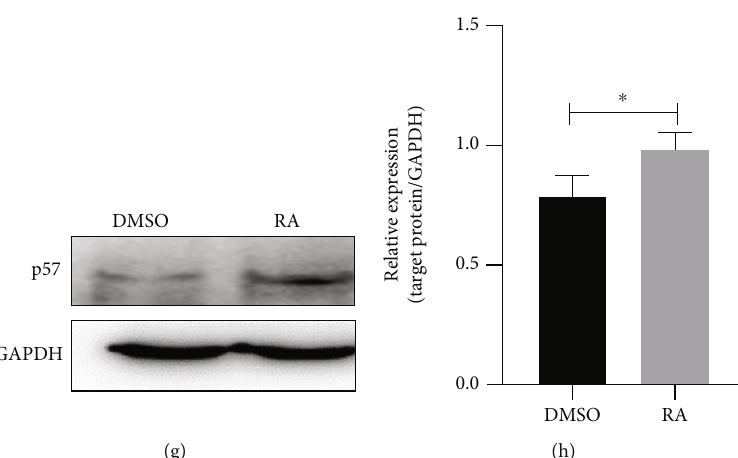
Figure 1: Increased p57 expression during mESC di ff erentiation. (a) The morphology of mESC-derived embryoid bodies (EBs) cultured for 3 days. (b) Real-time PCR analysis of p57 expression level during EB di ff erentiation from day 0 to day 3 ( n = 3 ). (c, d) Western blot and related densitometric analysis of p57 expression level during EB di ff erentiation from day 0 to day 3. (e) The morphology of mESCs treated with DMSO or RA for 48h. (f) Real-time PCR analysis of p57 expression level of DMSO- or RA-treated mESC ( n = 3 for both DMSO and RA-treated mESCs). (g, h) Western blot and related densitometric analysis of p57 expression level of DMSO- or